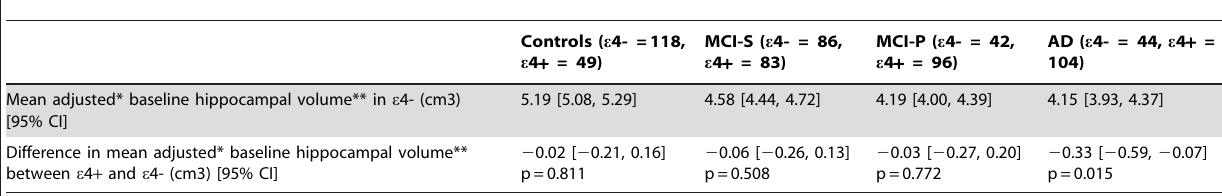
Table 2. Adjusted mean baseline hippocampal volumes for e 4 non-carriers and adjusted mean differences in total (left and right summed) baseline hippocampal volumes between e 4 carriers and non-carriers in controls, stable MCI, MCI progressors and AD (-ve sign means e 4 + , e 4-).